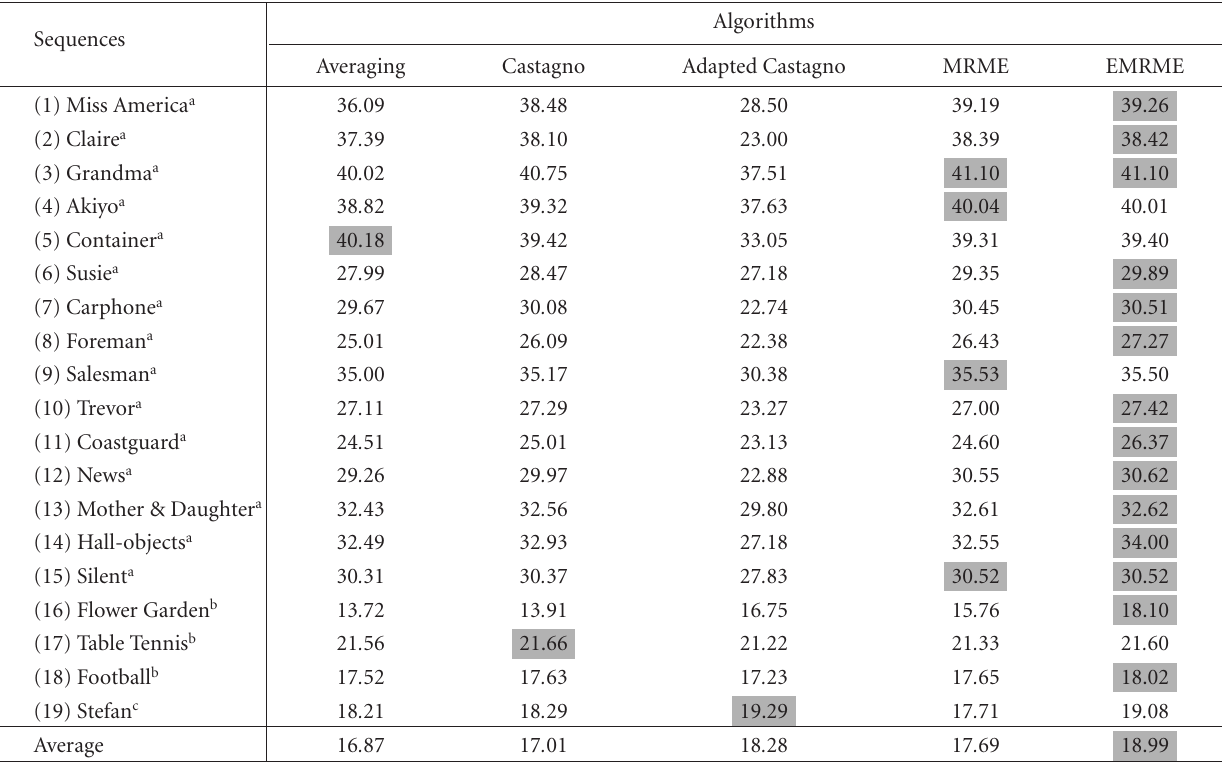
Table 2: Objective